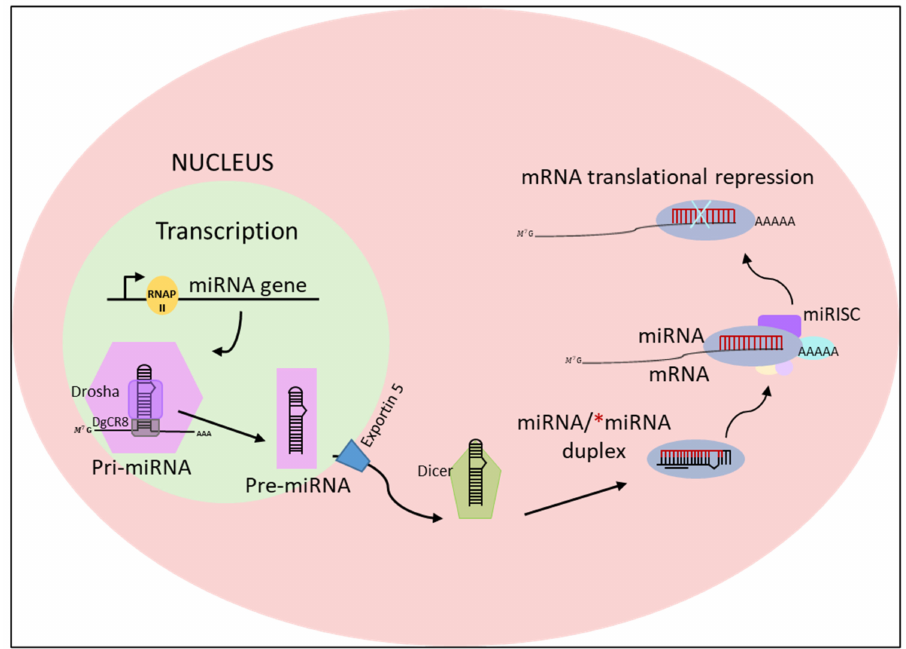
Figure 3. A schematic representation of miRNA biogenesis and function in eukaryotic cells. The biogenesis of a miRNA starts in the nucleus by RNA polymerase II, from a large 7-methylguanosine (m7G) capped and polyadenylated (poly(A) tail) transcript (pri-miRNA). This precursor is then processed by the RNase III enzyme Drosha and its cofactor Dgcr8 into a stem-looped structure called pre-miRNA. The pre-miRNA is then exported by exportin 5 into the cytoplasm where it becomes a mature miRNA after being processed by another Rnase III called Dicer. This process requires the removal of the final loop, resulting in a mature miRNA duplex. The mature miRNA binds the miRNA-induced silencing complex (miRISC), where base-pairing between the seed-sequence of miRNA and complementary sequences of mRNAs results in post-transcriptional gene